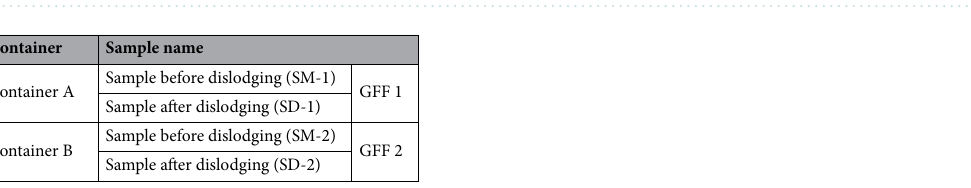
Table 1. Names of water samples collected for cyanobacterial